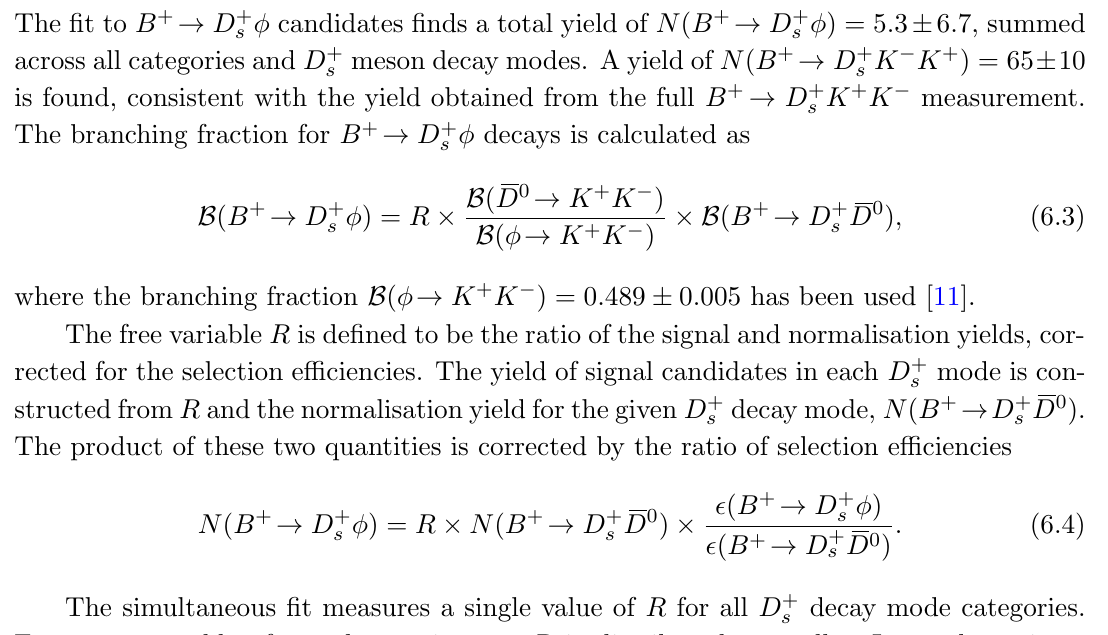
Figure 5. Projections of the background-subtracted two-body invariant masses (left) m ( D + and (right) m ( K + K (cid:0) ) for B + ! D + factor 1 =(cid:15) ratio